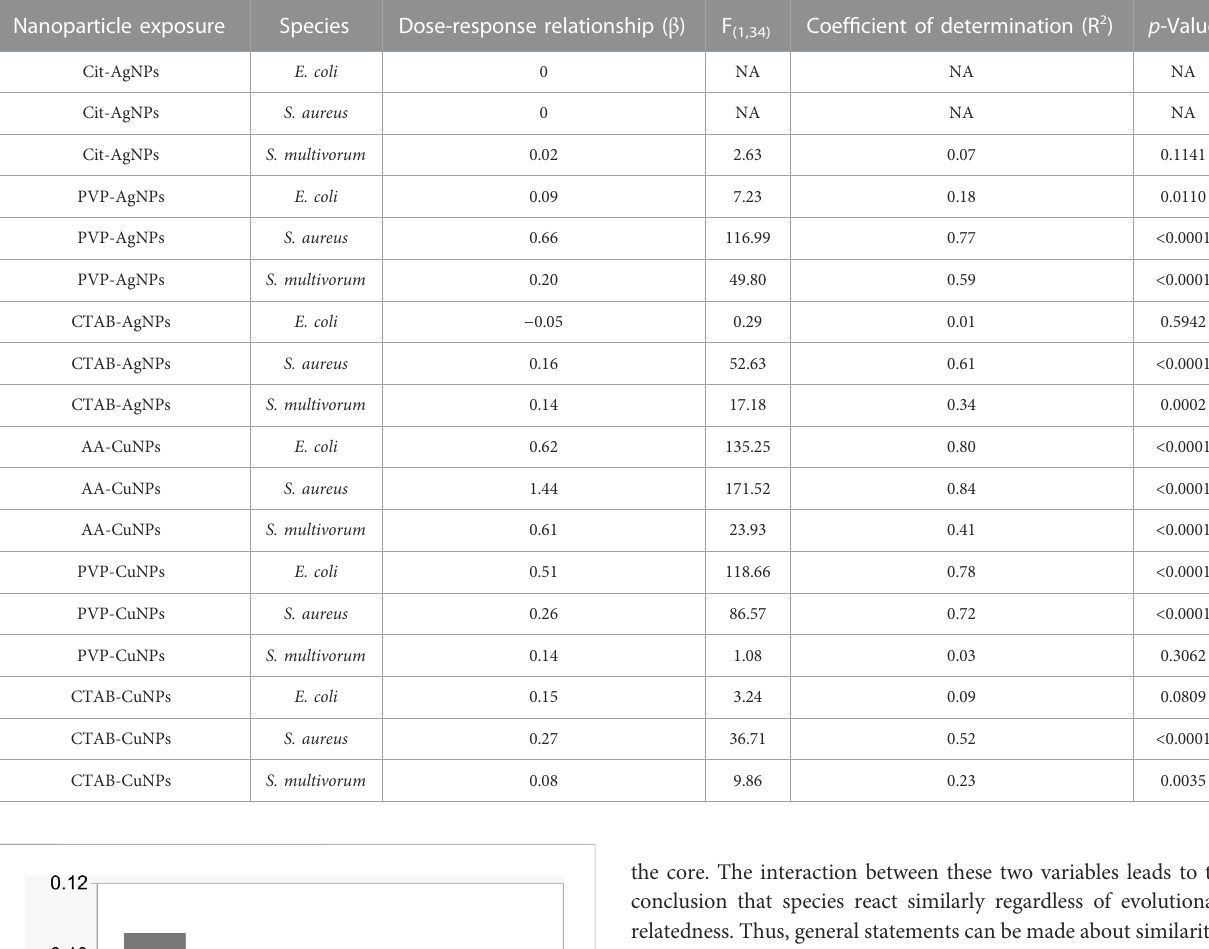
the core. The interaction between these two variables leads to the conclusion that species react similarly regardless of evolutionary relatedness. Thus, general statements can be made about similarities and differences in nanoparticle antibacterial properties. Interactions among the main factors were statistically signi fi cant (Figure 4). Core in fl uenced the relationship between surface coating and inhibition (F (2, 576) = 201.01, p < 0.0001, η 2 = 0.05). Cit-AgNPs induced almost no inhibition in bacterial growth while PVP-AgNPs and CTAB-AgNPs induced signi fi cantly greater levels of inhibition (least squares mean ± SD: Cit = 2.5 ± 0.003 mm; PVP = 1.94 ± 0.003 mm; CTAB = 3.14 ± 0.003 mm). All CuNPs, on the other hand, induced bacterial inhibition, but PVP-CuNPs induced signi fi cantly less inhibition than AA-CuNPs and CTAB-CuNPs (least squares mean ± SD: PVP = 0.49 ± 0.003 mm; AA = 4.93 ± 0.003 mm; CTAB = 3.26 ± 0.003 mm). Dose in fl uenced the relationships between surface coating and core with inhibition. In E. coli , PVP-AgNPs showed a relatively constant zone of inhibition over the dosing concentrations (1, 2, 4, and 8 nM), while the zone of inhibition within CTAB-AgNP treatment exhibited the greatest inhibition at the lowest concentration tested. The zones of inhibition within all CuNP treatments where greatest at the highest concentration. Most notably, the mean zone of inhibition within AA- CuNP treatment is 4.53 mm at 8 nM and within PVP-CuNP treatment is 3.39 mm at 8 nM, which are some of the largest inhibition zone mean values observed in this study. Figure 5 shows comparisons of the variables used in the study.